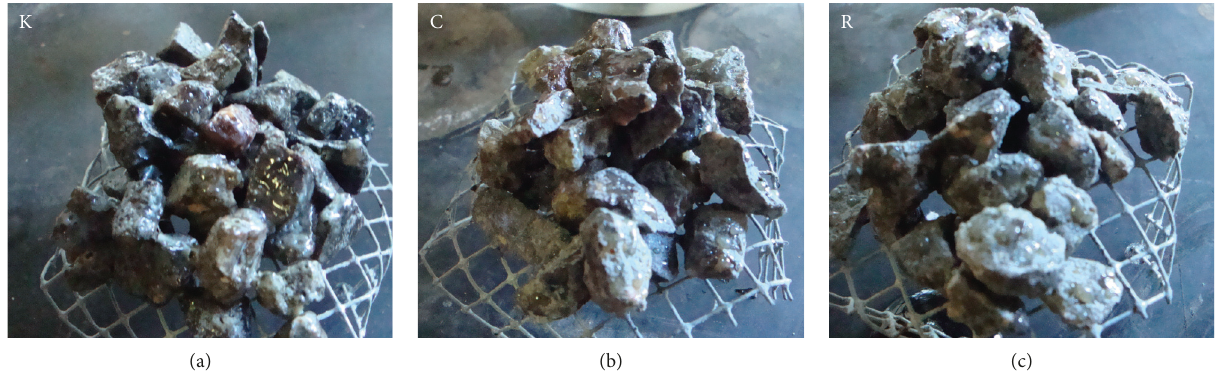
Figure 4: Siliceous aggregate and binder systems after AST.